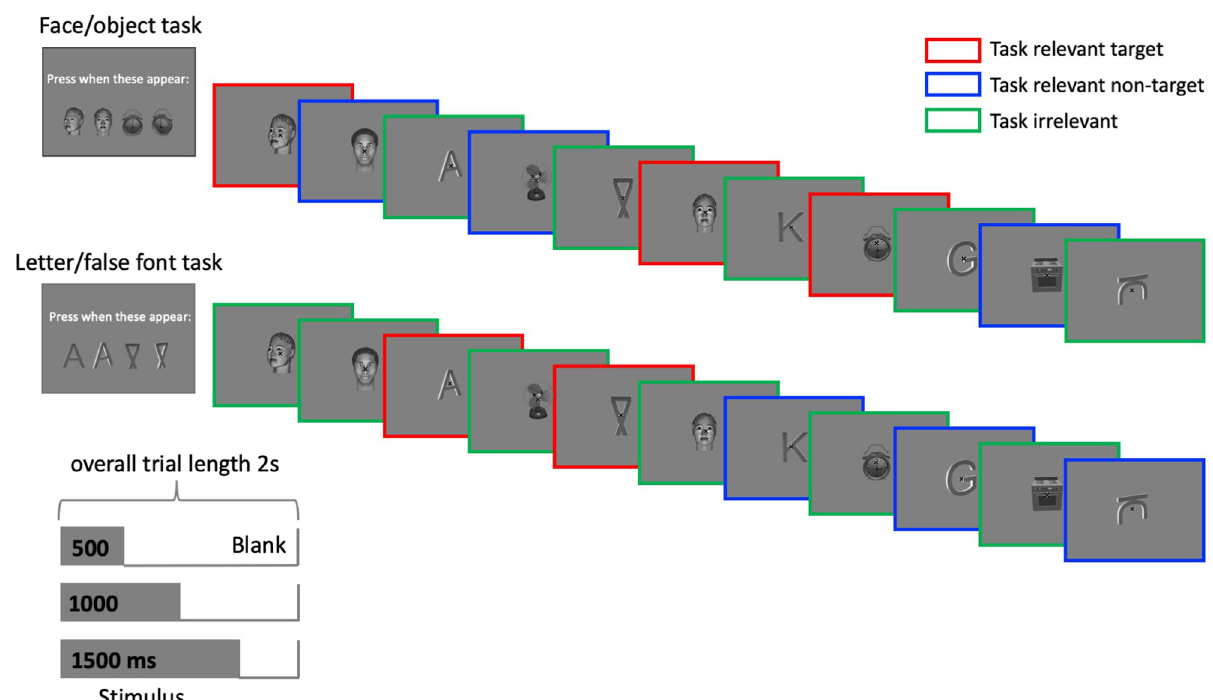
Fig 2. Experiment 1 design—In separate blocks (top & bottom rows), subjects will be asked to detect infrequent targets drawn from two categories: a specific face and a specific object (upper row), or a specific letter and a specific false-font (lower row). The stimuli will be shared across blocks, but the selection of the targets will determine to which of three trial types each stimulus belongs: task-relevant targets , task-relevant non-targets , task-irrelevant non-targets highlighted by red, blue and green frames respectively. Colored frames are shown for illustration purposes only. The duration (500, 1000, 1500 ms) and orientation (side view/front view) of stimuli will be manipulated to allow for specific analyses. Blank intervals between stimuli and intertrial intervals (truncated exponential distribution) are not depicted